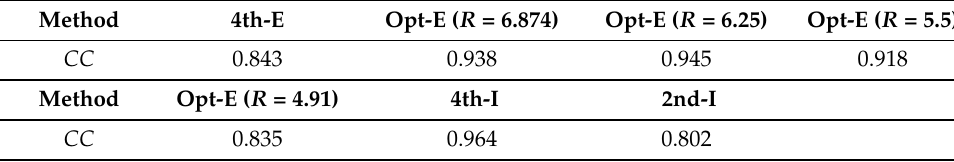
Table 1. Comparison of CC values among various